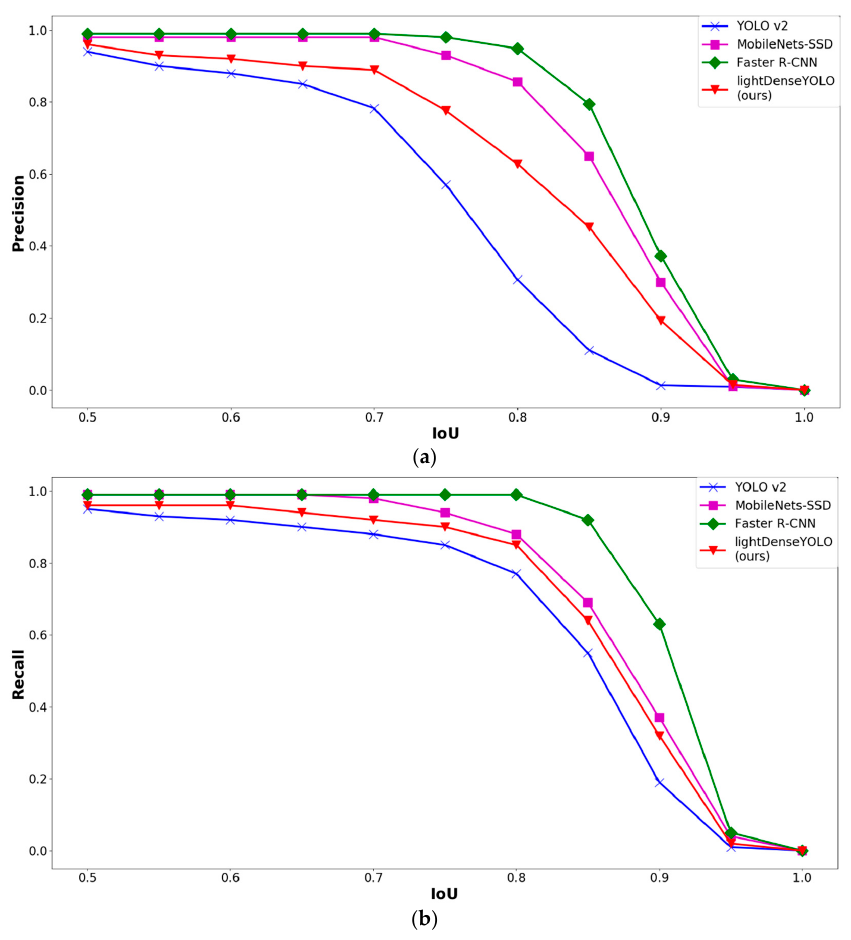
Figure 13. Comparative graphs of ( a ) precision and ( b ) recall by different CNN marker detectors according to intersection over union (IoU) threshold.